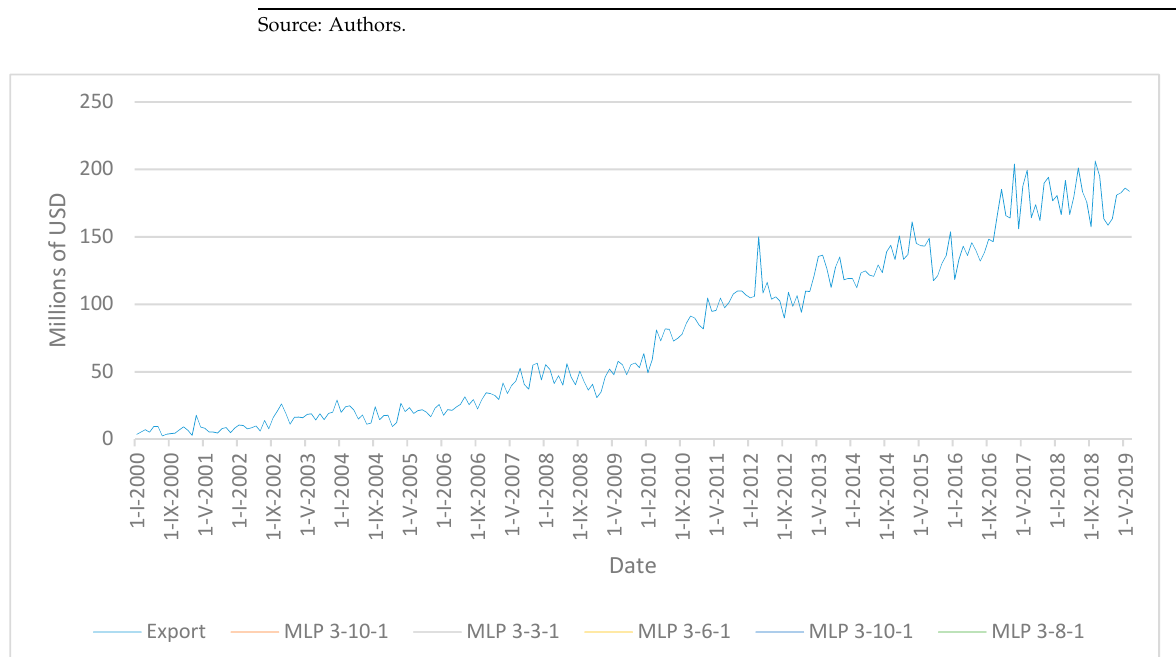
Table 4 . Retained neural networks from Experiment 2 .